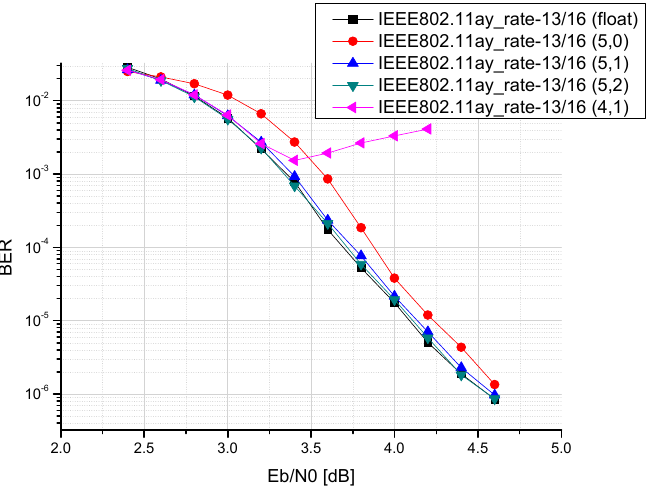
Figure 17. Fixed-point simulation in IEEE 802.11ay R = 13/16.